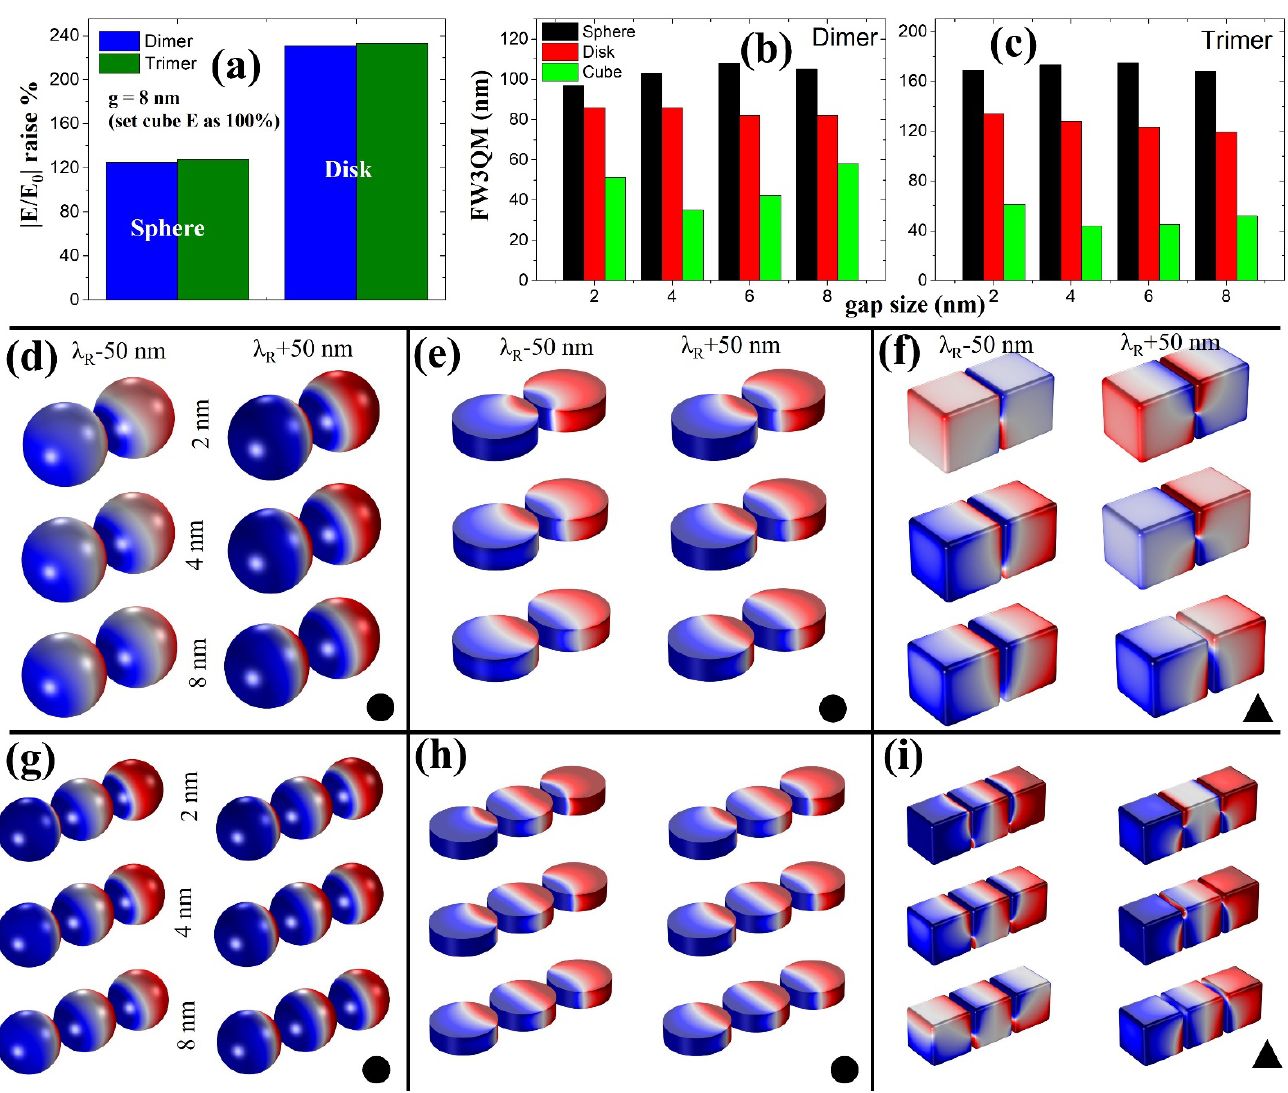
Figure 5. ( a ) Calculated |E/E 0 | raise% for sphere- and disk-based dimer and trimer NPs at g = 8 nm compared to a cube. ( b ) FW3QM results of dimers ( b ) and trimers ( c ) for different gap sizes ranging from 2 nm to 8 nm reveals sphere-based NPs can perform better. The 3DSCM profiles indicating plasmonic mode characteristics of a sphere, disk, and cube NPs taken at λ R ± 50 nm wavelength positions for dimer ( d – f ) and trimer ( g – i ) nanostructures. Here λ R represents resonance wavelength position as seen from Figure 1c,d. All 3DSCM profiles are arranged to follow gap sizes of 2 nm, 4 nm, and 8 nm. Solid circle (dipole) and triangle (quadrupole) symbols represent the plasmonic modes. In 3DSCM profiles, blue represents negative charge and red denotes positive charge.